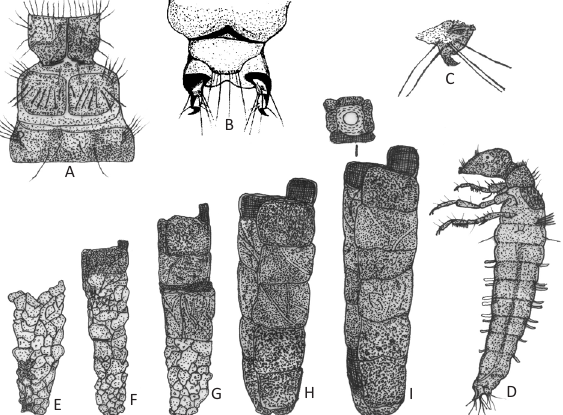
Figure 5. Larva of Lepidostoma nuburagangai sp. nov. A - thorax, dorsal; B - abdominal segment IX, dorsal; C - left anal claw, left lateral; d - body, left lateral; E - case of first instar (anterolateral); F - case of second instar (anterolateral); G - case of third instar (anterolateral); H - case of fourth instar (anterolateral); I - case of final instar